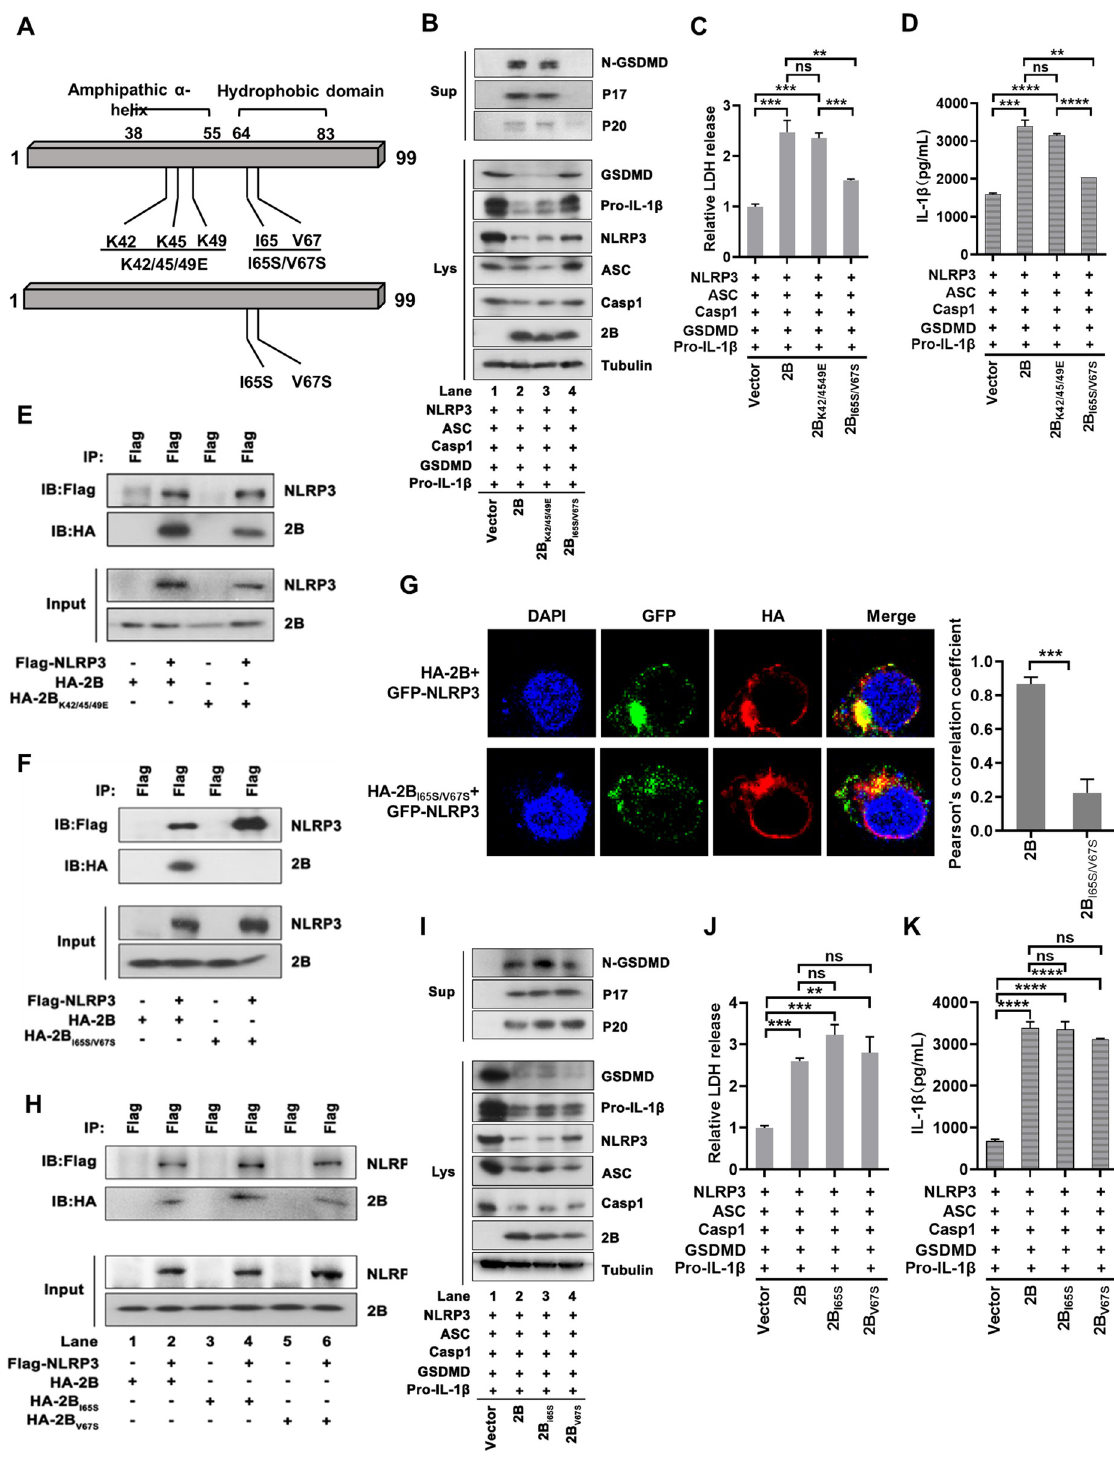
Fig 6. I65 and V67 are the key sites for ECHO 11 2B activating NLRP3 inflammasome. ( A ) Schematic representation of two ECHO 11 2B mutants, K42/45/49E and I65S/V67S. ( B-D ) 293T cells were co-transfected with plasmids encoding NLRP3, ASC, CASP-1, GSDMD, pro-IL- 1 β , together with the empty vector, 2B WT , 2B K42/45/49E or 2B I65S/V67S . GSDMD-N, P20 and P17 in the supernatants, and GSDMD, NLRP3, ASC, CASP-1, pro-IL-1 β and 2B in the lysates were examined by Western blotting. ( C ) The LDH release in the supernatants were determined by cytotoxicity assay, and the level of LDH in cells transfected with the empty vector was defined as 1-fold. ( D ) Mature IL-1 β